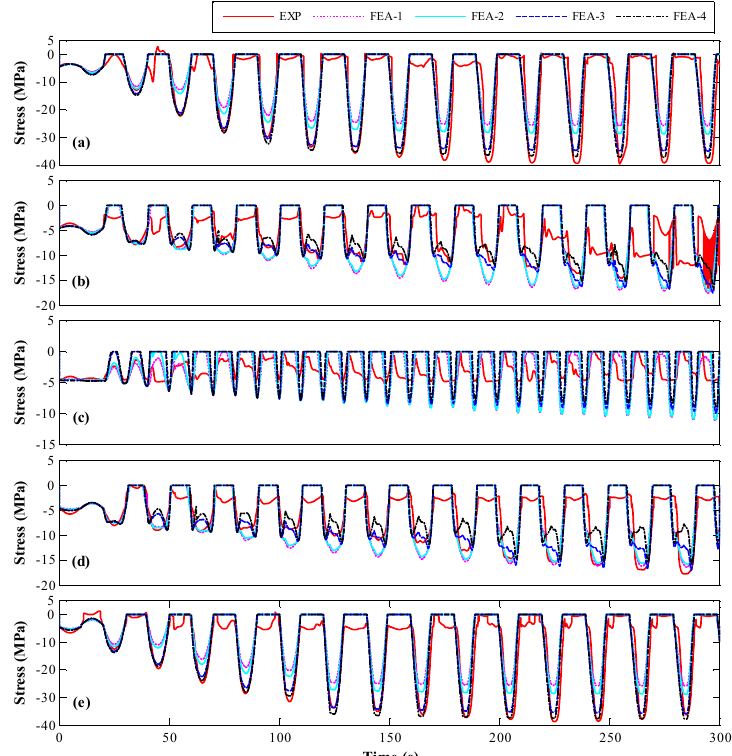
Figure 9. Stress time-history for experiment and finite element analysis at: ( a ) Point I; ( b ) Point II; ( c ) Point III; ( d ) Point IV; and ( e ) Point V.